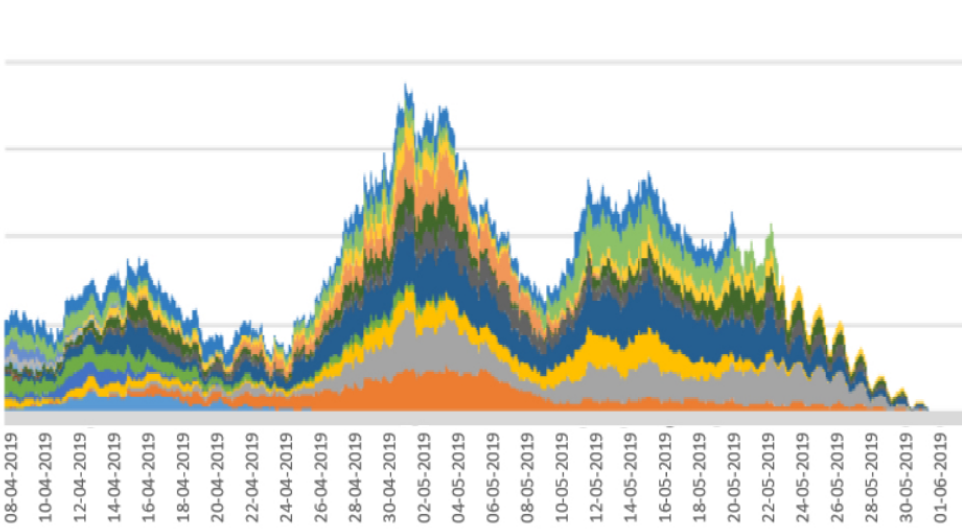
Figure 4. Stacked line graph for aligned periodicity intensities for 19 contributing calves. Each colour represents a different